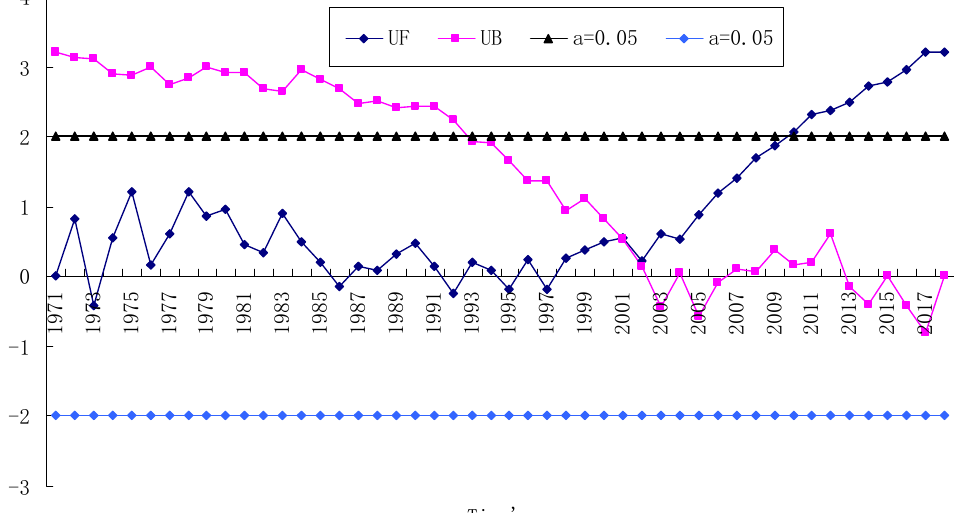
Figure 3. M-K test of the trends of annual average temperature changes during the summer and autumn seasons in Fujian from 1971 to 2018.